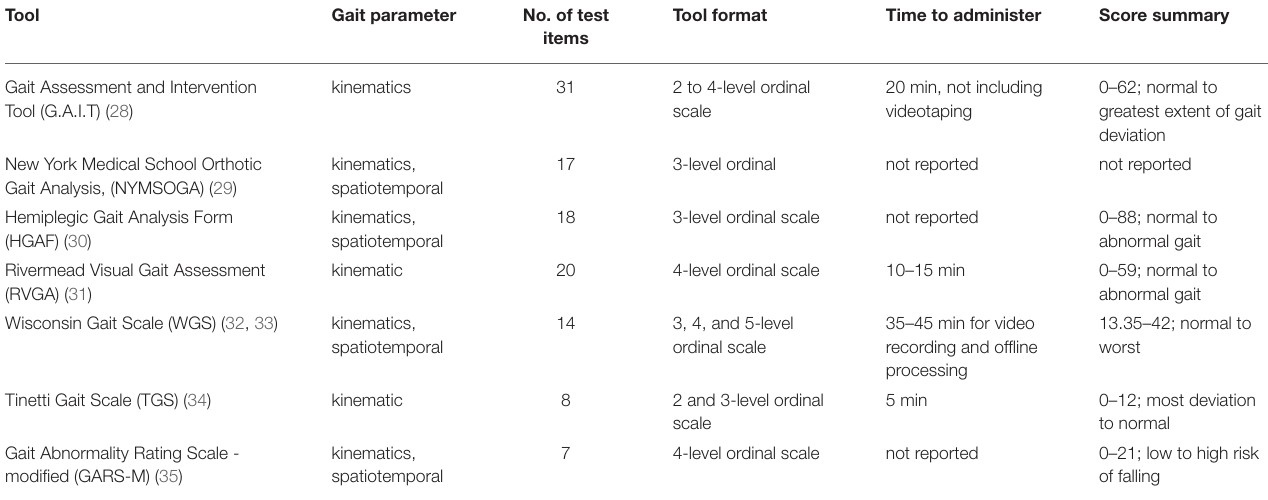
TABLE 2 | Observational gait scales and characteristics.